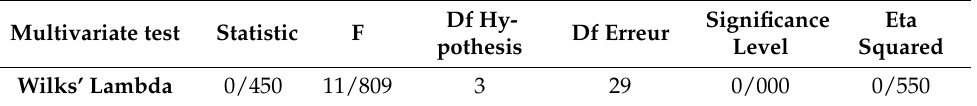
Table 5. Multivariate analysis of the components of academic enthusiasm considering the experimen- tal and control groups as an independent variable based on Wilks’ Lambda statistic.